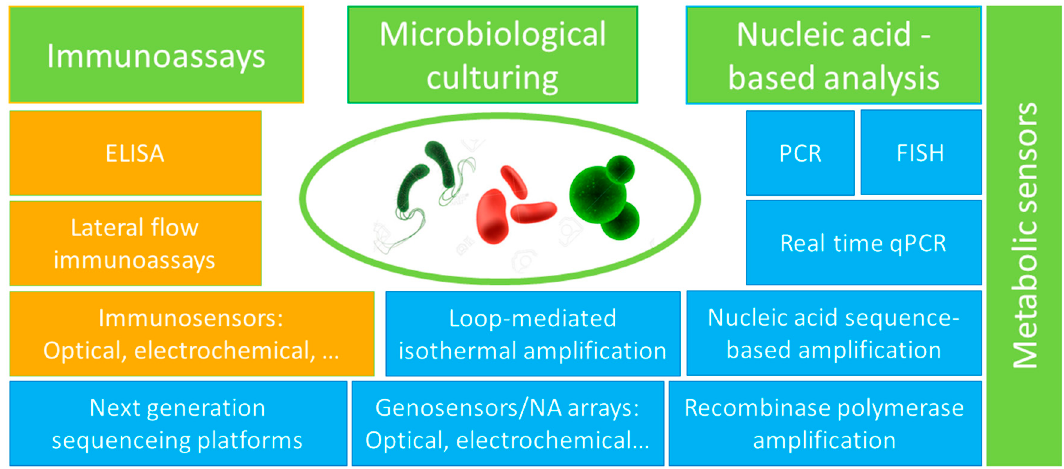
Figure 1. Existing methodologies for bacterial analysis.